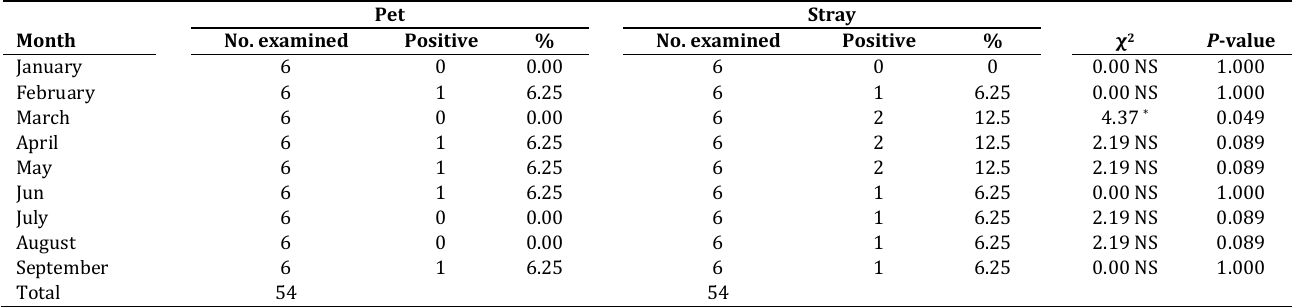
Table 2 . Dipylidium caninum infection rates in pet and stray dogs according to the months Pet Stray